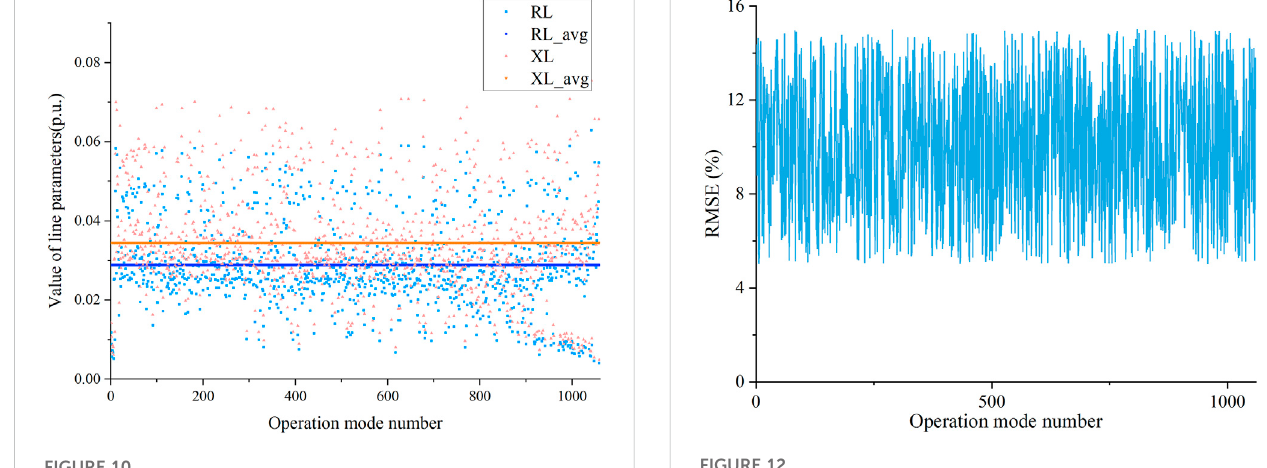
Comparison of equivalent line parameters and their averages.